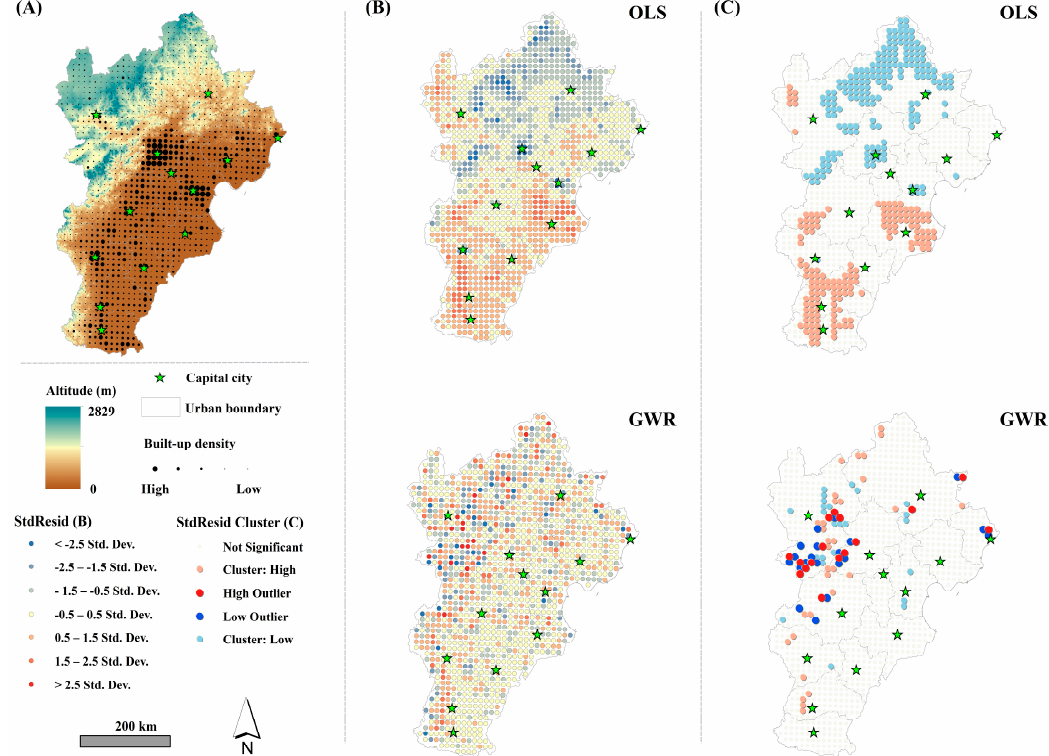
Figure 6. Spatial statistical plots for the standard residuals (StdResid) of the ordinary least squares (OLS) and geographically Figure 6 weighted regression (GWR) models with the case of 12 km grid in 2015, ( A ) Spatial information of the BTH region, ( B ) Spatial distribution of the StdResid for each grid by the OLS and GWR models, and higher absolute value of StdResid indicate higher deviation of regression prediction, ( C ) The LISA map (by Anselin local Moran (cid:48) s I analysis) for the StdResid of the OLS and GWR models, of which the red and blue dot clusters represent the spatial cluster of high value and low values of the StdResid respectively.